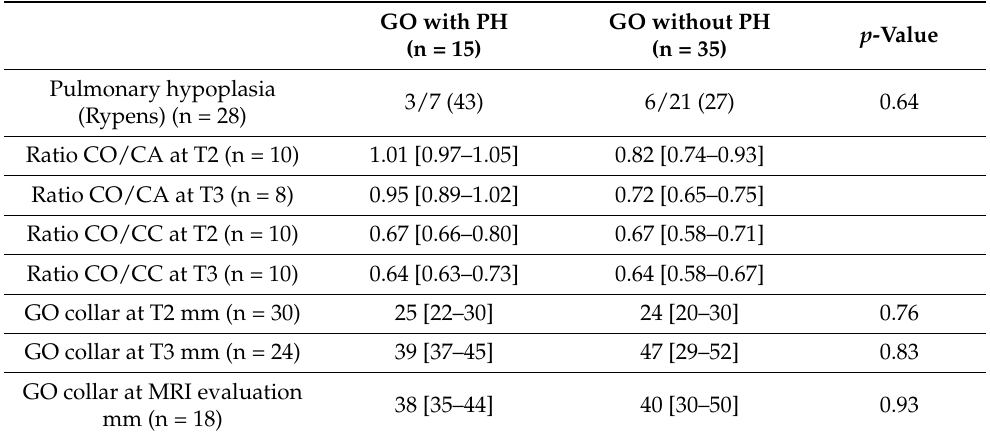
Table 1. Antenatal characteristics.